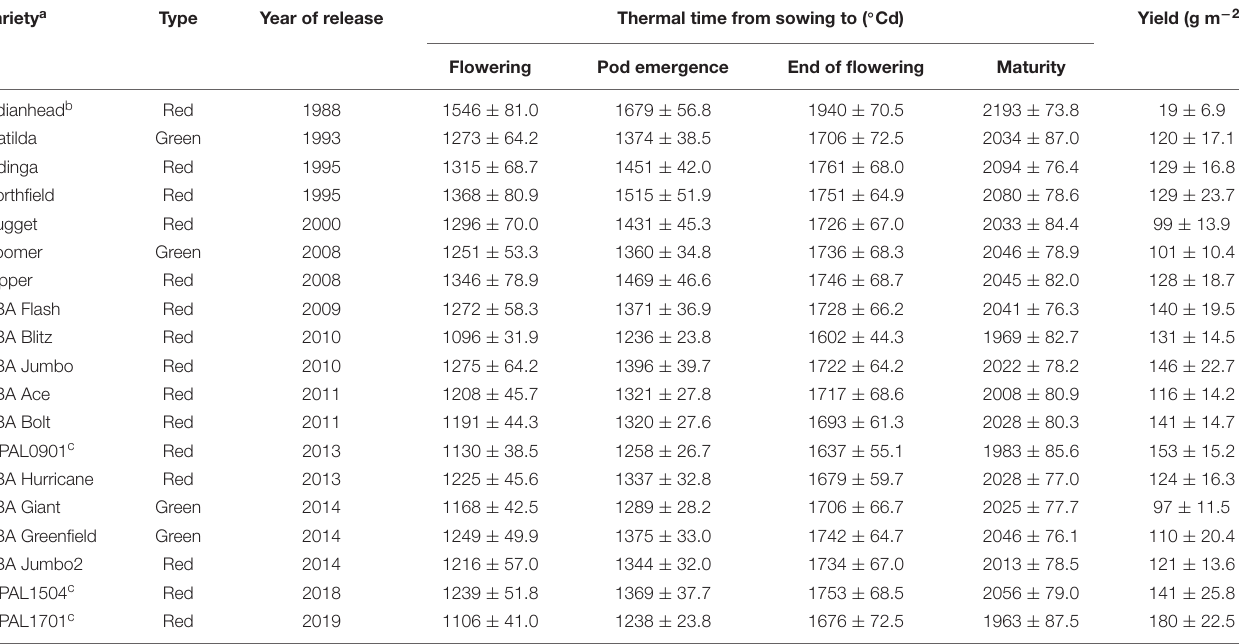
TABLE 1 | Seed type, phenology, and yield of 19 lentil varieties. Variety